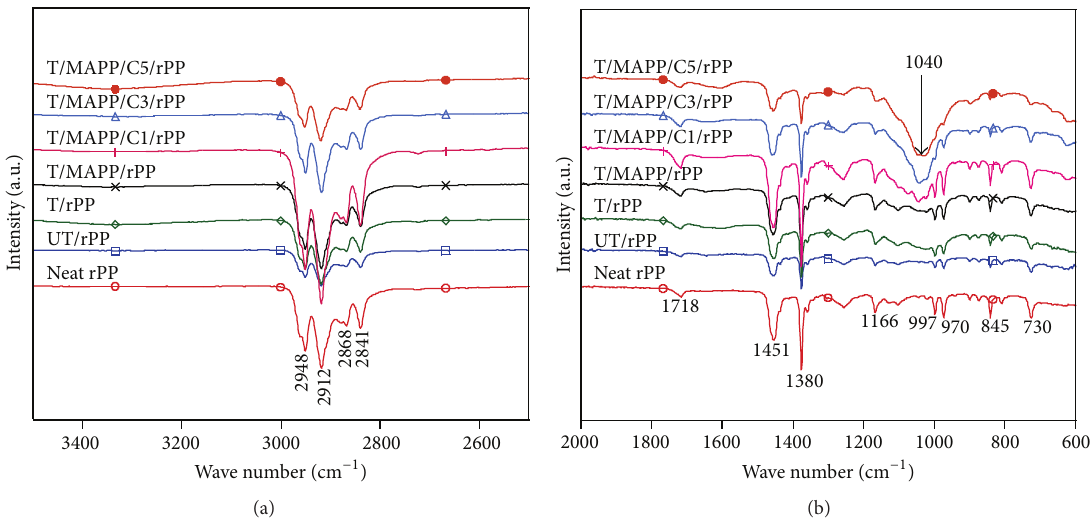
Figure 2: FTIR analysis of neat rPP and 40 wt.% sisal fiber and nanoclay reinforced polypropylene